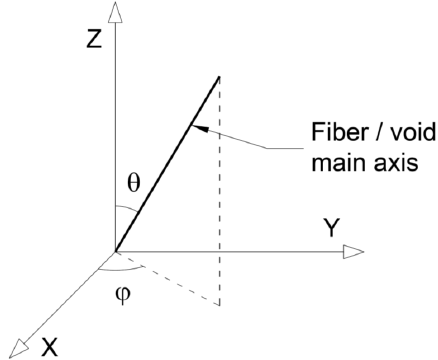
Figure 12. Identification of θ (theta) and φ (phi) angles.